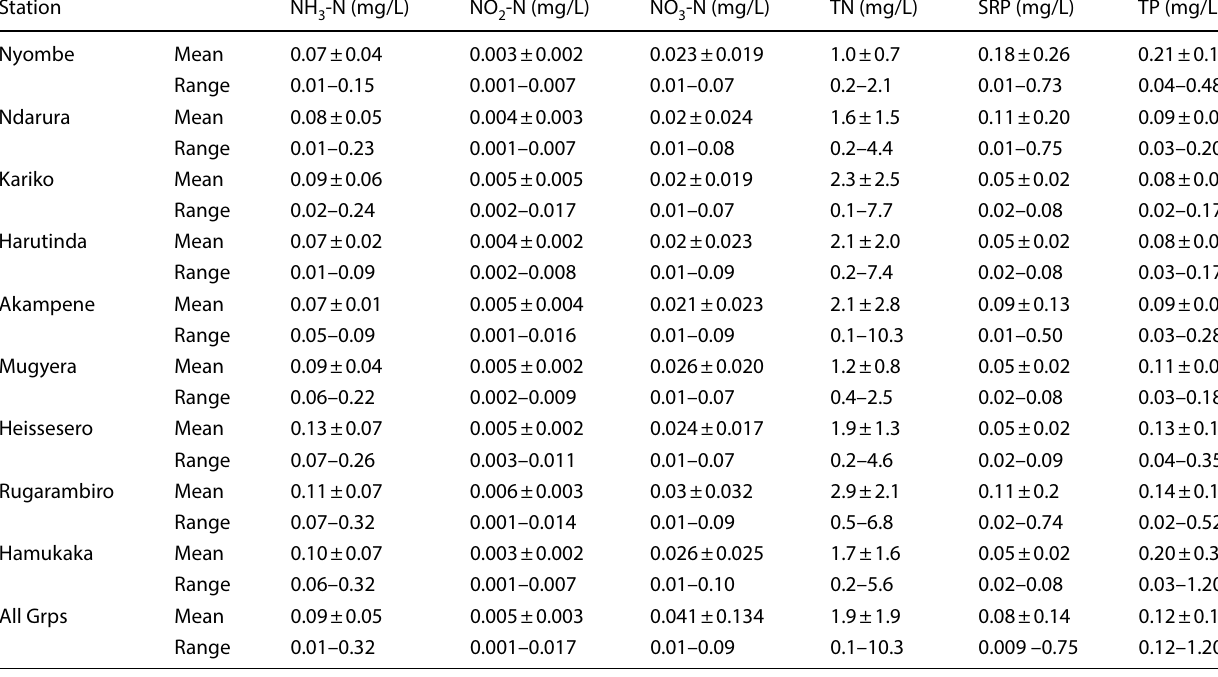
Table 4 Mean ± SD of nutrients concentration at different sampling points ( n = 108) Station